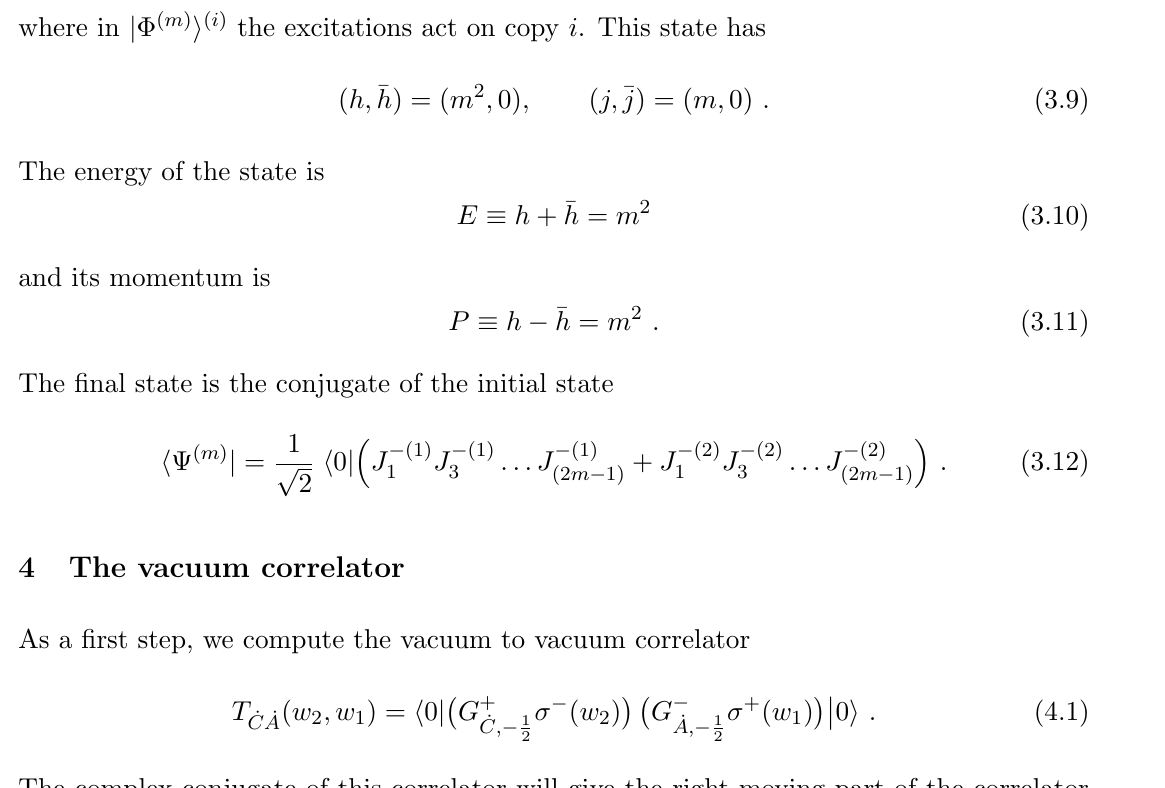
, the (cid:12)nal state 2 (cid:27) + and G + (cid:27) (cid:0) at w 1 = 0 and w 2 = w , _ A _ C